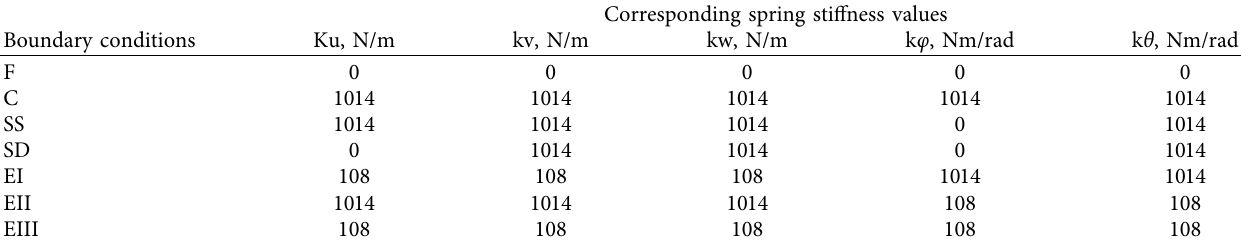
Table 1: The corresponding values of the spring stiffness for general boundary conditions.